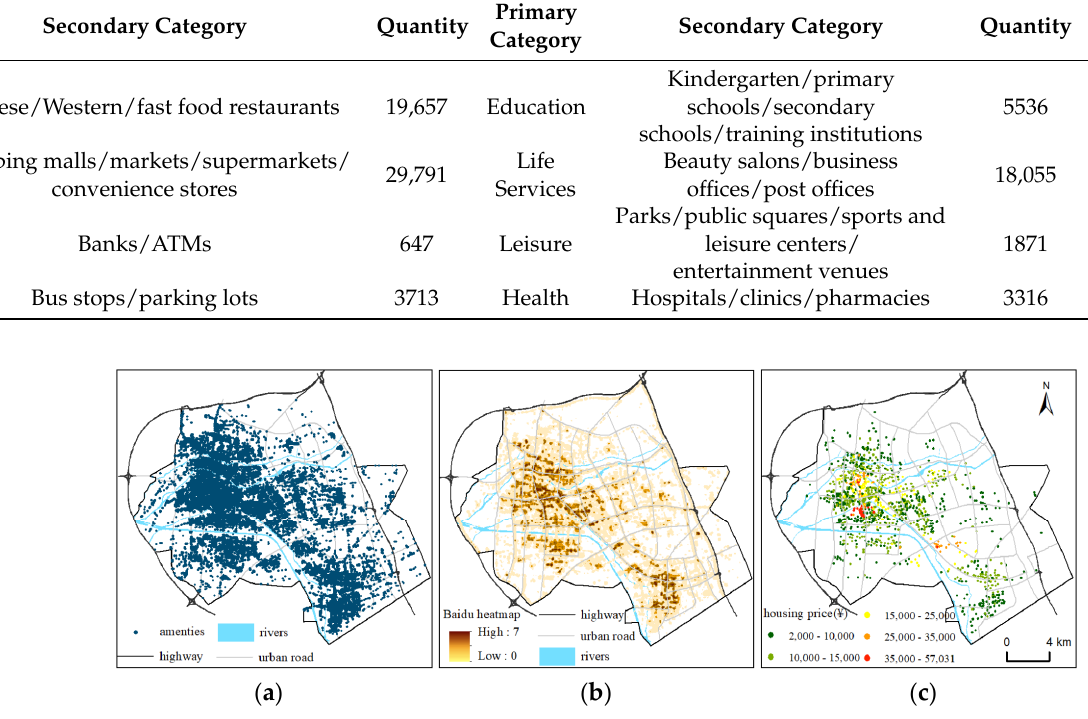
Figure 2. Spatial distribution of Supply and Demand data. ( a ) the distribution of all amenities; ( b ) the distribution of Baidu population heatmap data; ( c ) the distribution of residential housing prices. Table 1. Classification of urban amenities.